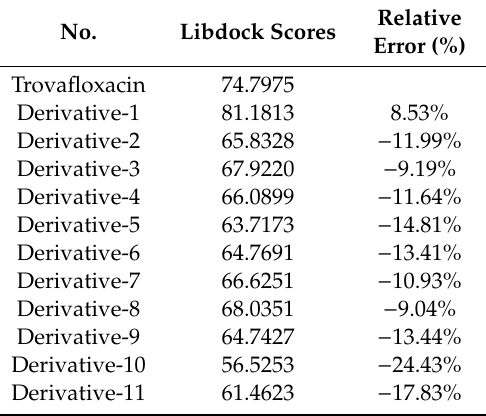
Table 6. Docking results of target molecule and TRO derivatives with plasma